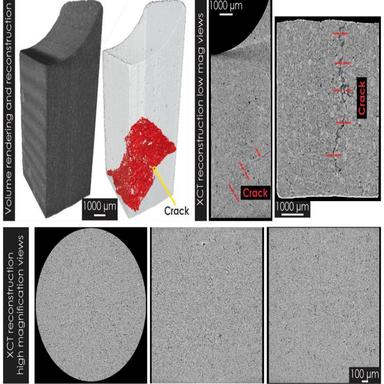
XCT of CGB graphite showing a crack produced by the infiltration of the carbon foam.